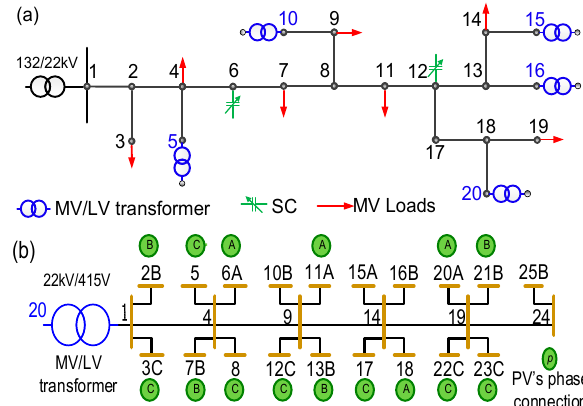
Figure 5. Considered 145-bus Australian distribution network: ( a ) Medium-voltage (MV) feeder; ( b ) unbalanced low-voltage (LV) feeder supplied from bus-20 of the MV feeder.